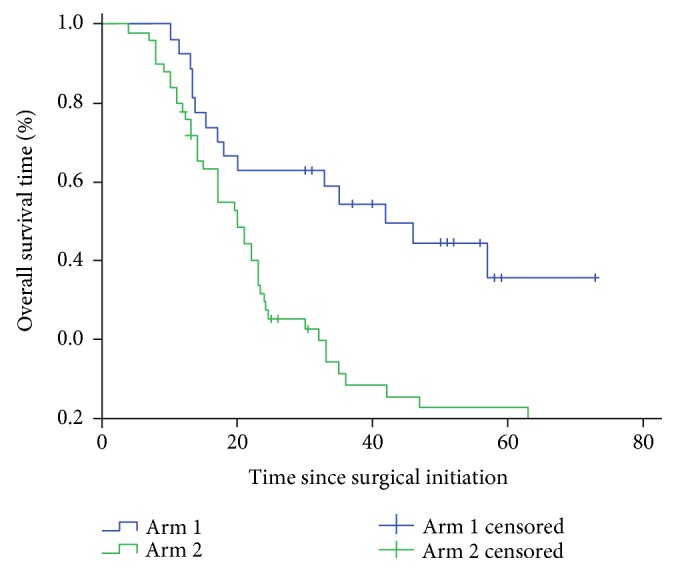
Overall survival time of Arm 1 versus Arm 2 was calculated using 27 patients in Arm 1 compared with 50 patients in Arm 2.